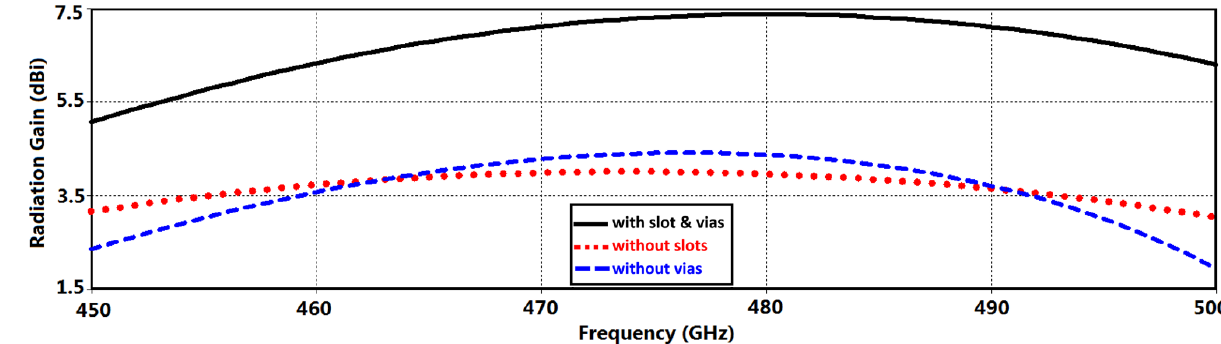
Figure 3. Radiation gain as a function of the frequency of the proposed AoC (i) without metamaterial slots, (ii) without metallic vias, and (iii) with metamaterial slots and metallic vias.